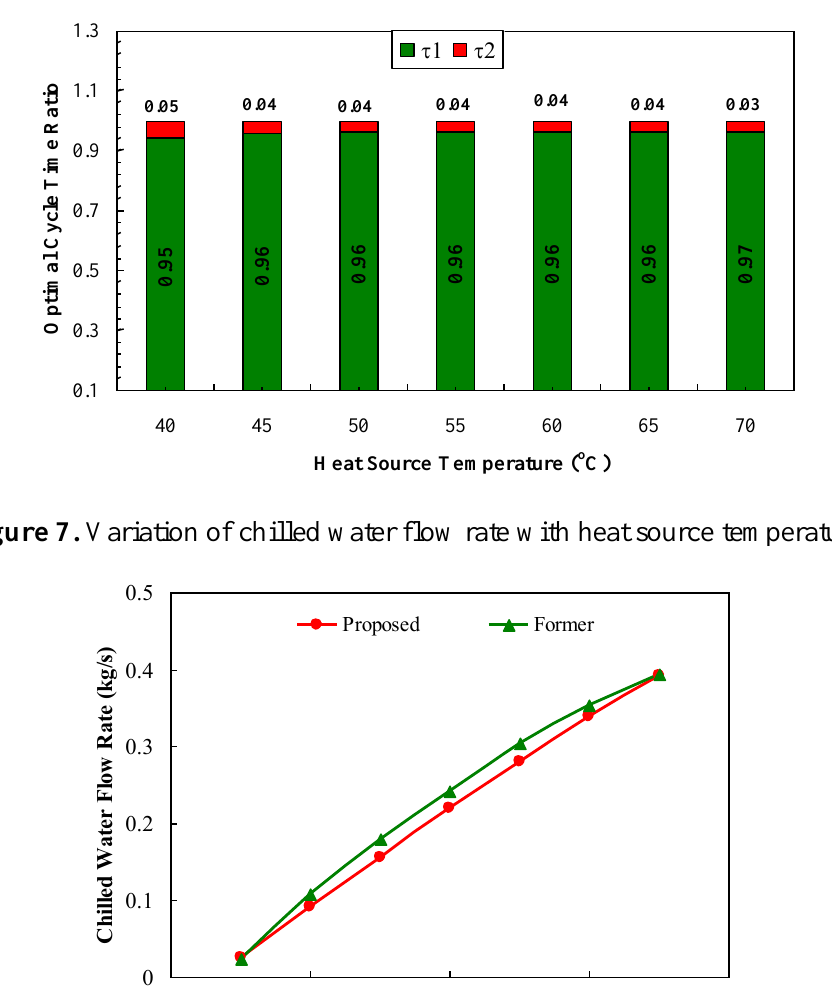
Figure 6. Optimal cycle time ratio of former six-bed three-stage cycle for different heat source temperature.